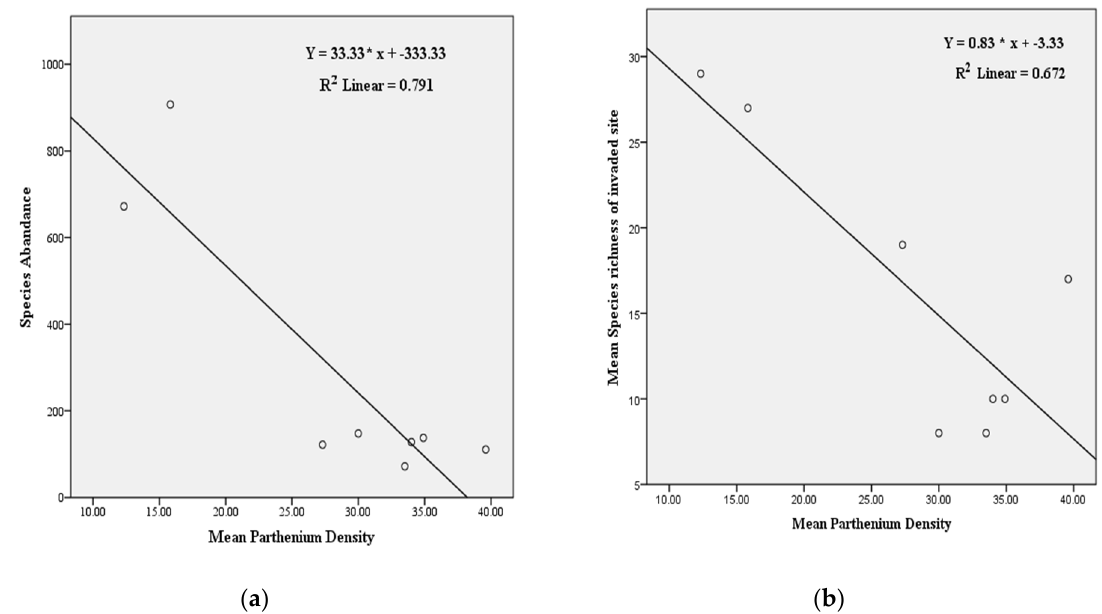
Figure 4. The relationship between mean P. hysterophorus density with species abundance and richness. ( a ). Mean P. hysterophorus density vs. mean species abundance. ( b ). Mean P. hysterophorus density vs. mean richness.